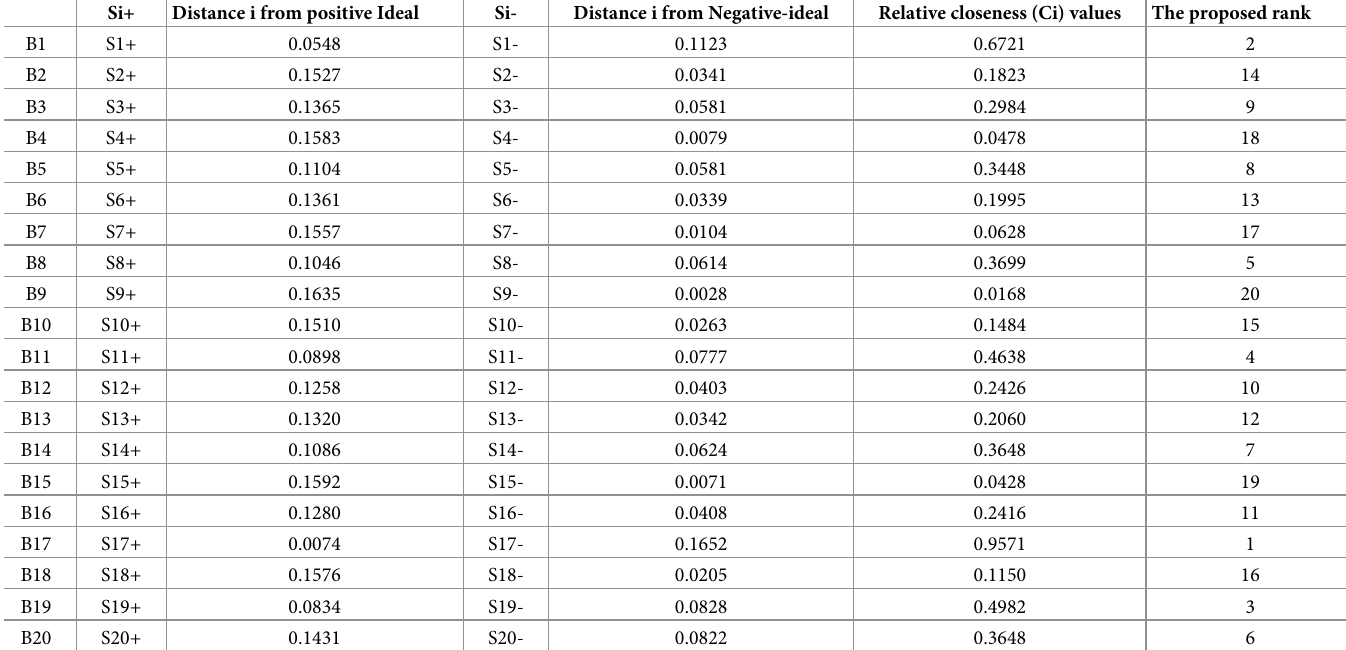
Table 5. Euclidean separation